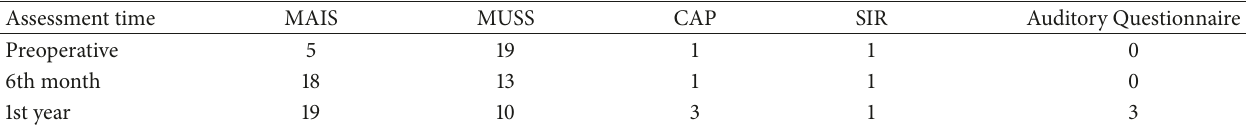
Table 2: Auditory integration test results for Case 2 .